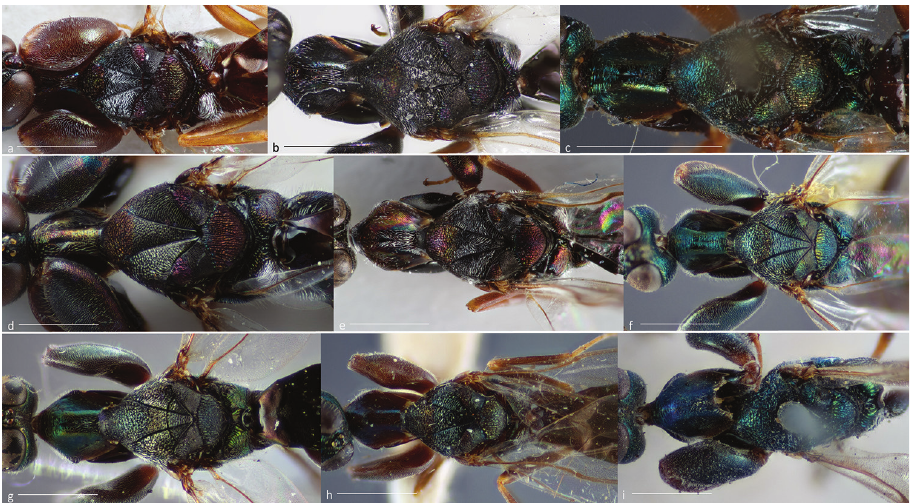
Figure 13. Mesosoma (dorsal) III a O. magnifica (Risbec) (imaged specimen: OMag01, holotype) b O. mkomaziensis sp. n. (OMk01, holotype) c O. monstrum syn. n. (OFo12, paratype) d O. namibiensis sp. n. (ONa01, holotype) e O. niehuisorum sp. n. (ONi01, holotype) f O. pumilae Yang (OPu01, paratype) g O. regiae Yang (ORe01, paratype) h O. srilankiensis sp. n. (OSr01, holotype) i O. tenuicollis (Walker) (OTe01, holotype). Scale bars: 1